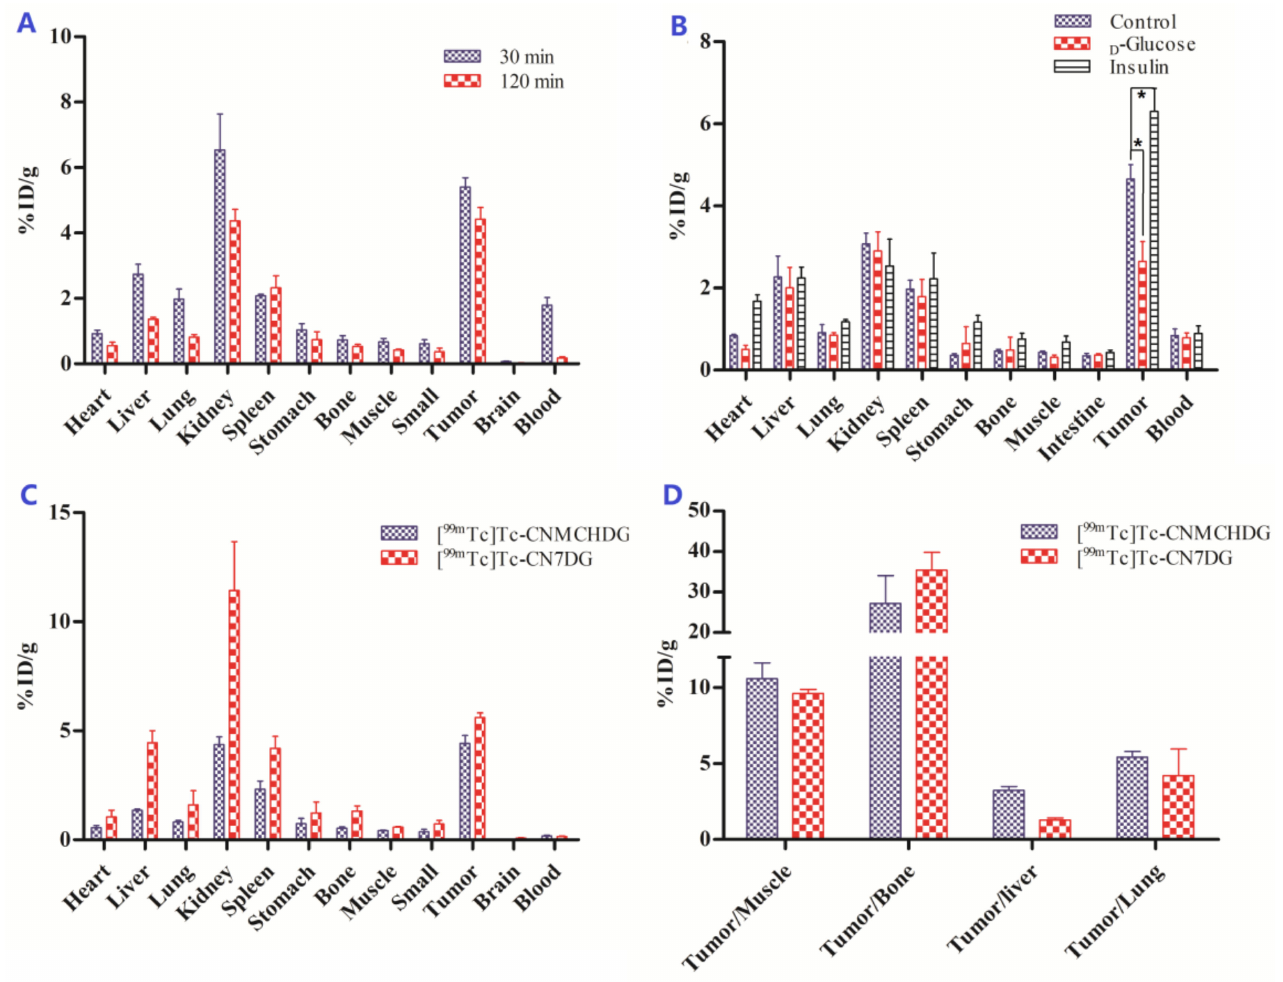
Figure 4. ( A ) Biodistribution of [ 99m Tc]Tc-CNMCHDG in A549 tumor-bearing mice at 30 min and 120 min post-injection ( n = 3). ( B ) Biodistribution of [ 99m Tc]Tc-CNMCHDG in S180 tumor-bearing mice at 60 min post-injection with pre-treatment of saline (control), 2-deoxy- D -glucose (6 mg), or insulin (0.25 units) (* p < 0.05, n = 5). ( C ) Comparison of the biodistributions of [ 99m